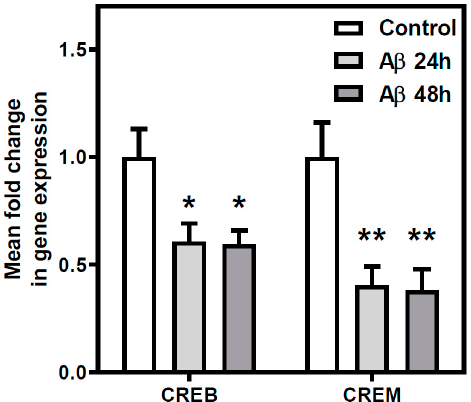
Figure 7. A β 25-35 effect on the expression of cyclic AMP-dependent transcription factors. The expression of the cAMP-dependent transcription factors CREB and CREM was measured using qPCR. Rat cortical neurons were exposed to 25 µ M A β 25-35 for 24 h, 48 h, or maintained under control conditions prior to RNA isolation. A β 25-35 exposure reduced the expression of CREB and CREM. Histograms represent mean ± SEM values obtained from three independent experiments performed in duplicate using different preparations. * p < 0.05 and ** p < 0.01 significantly different from control value using one-way ANOVA and Bonferroni’s post hoc test.